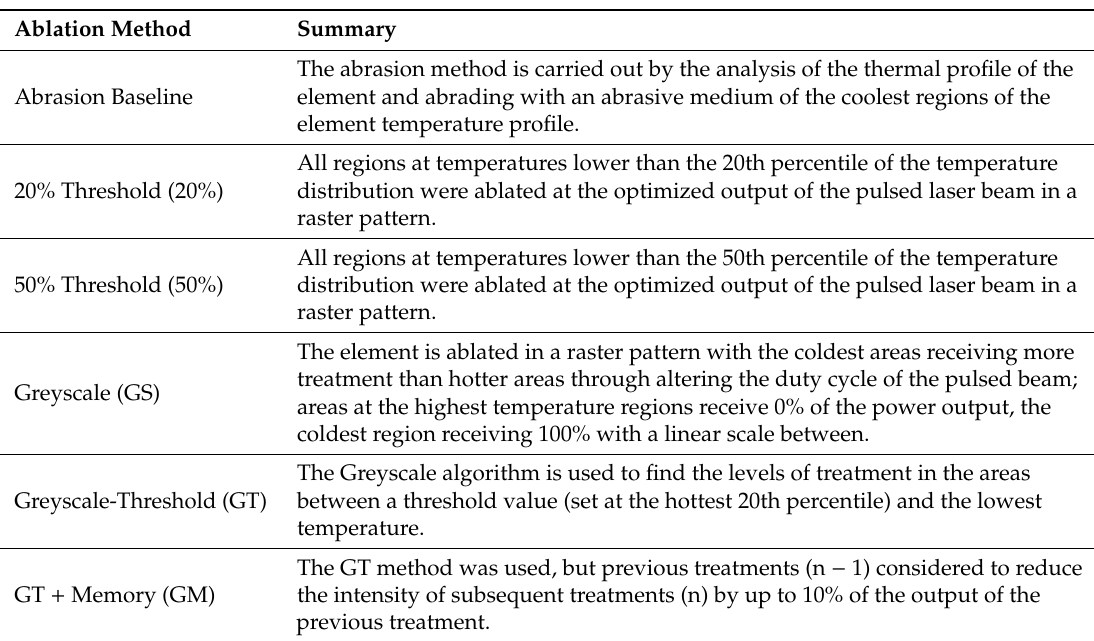
Table 3. Descriptions of the various processing methods